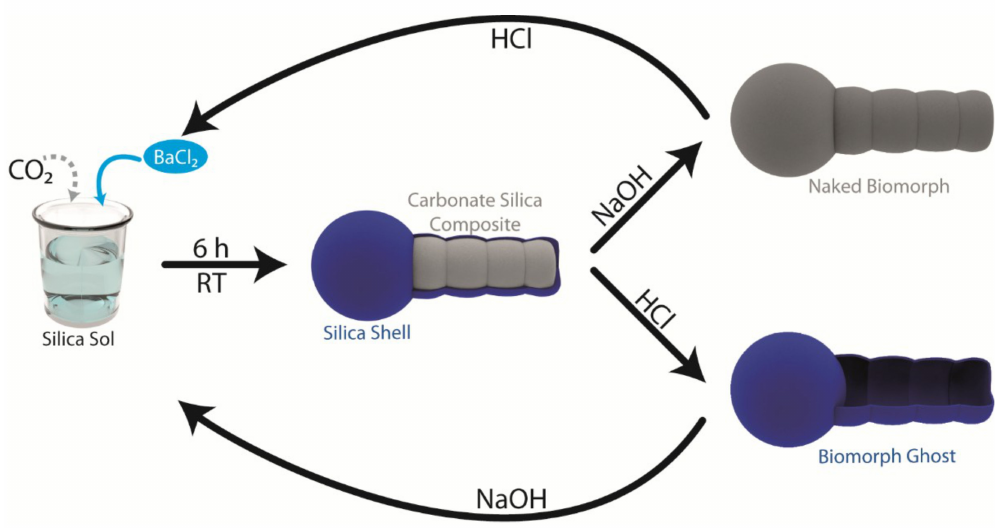
Figure 1. Schematic illustration of biomorph formation at room temperature (RT) and pathways